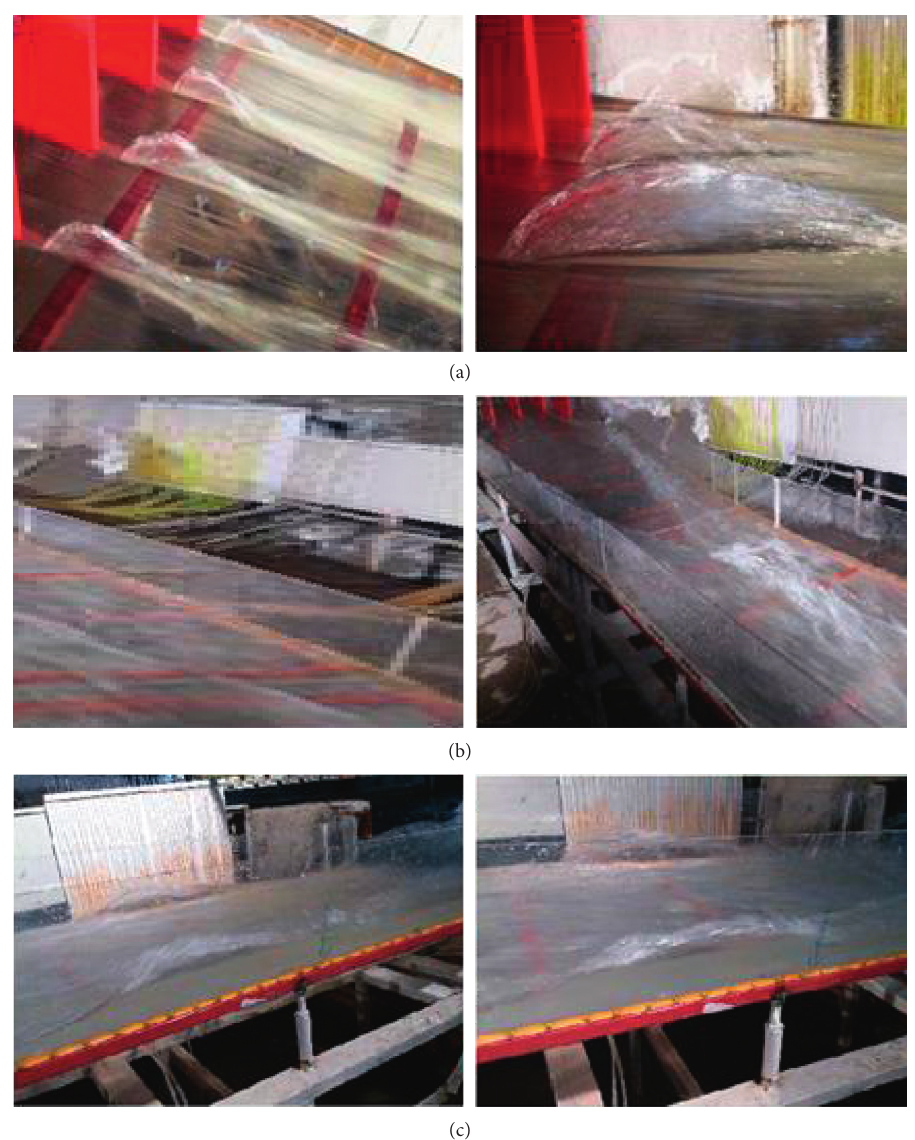
Figure 6: The shockwaves created over the chute. (a) Pier waves or wave 1. (b) Middle wave or wave 2. (c)Wave at the wall or wave